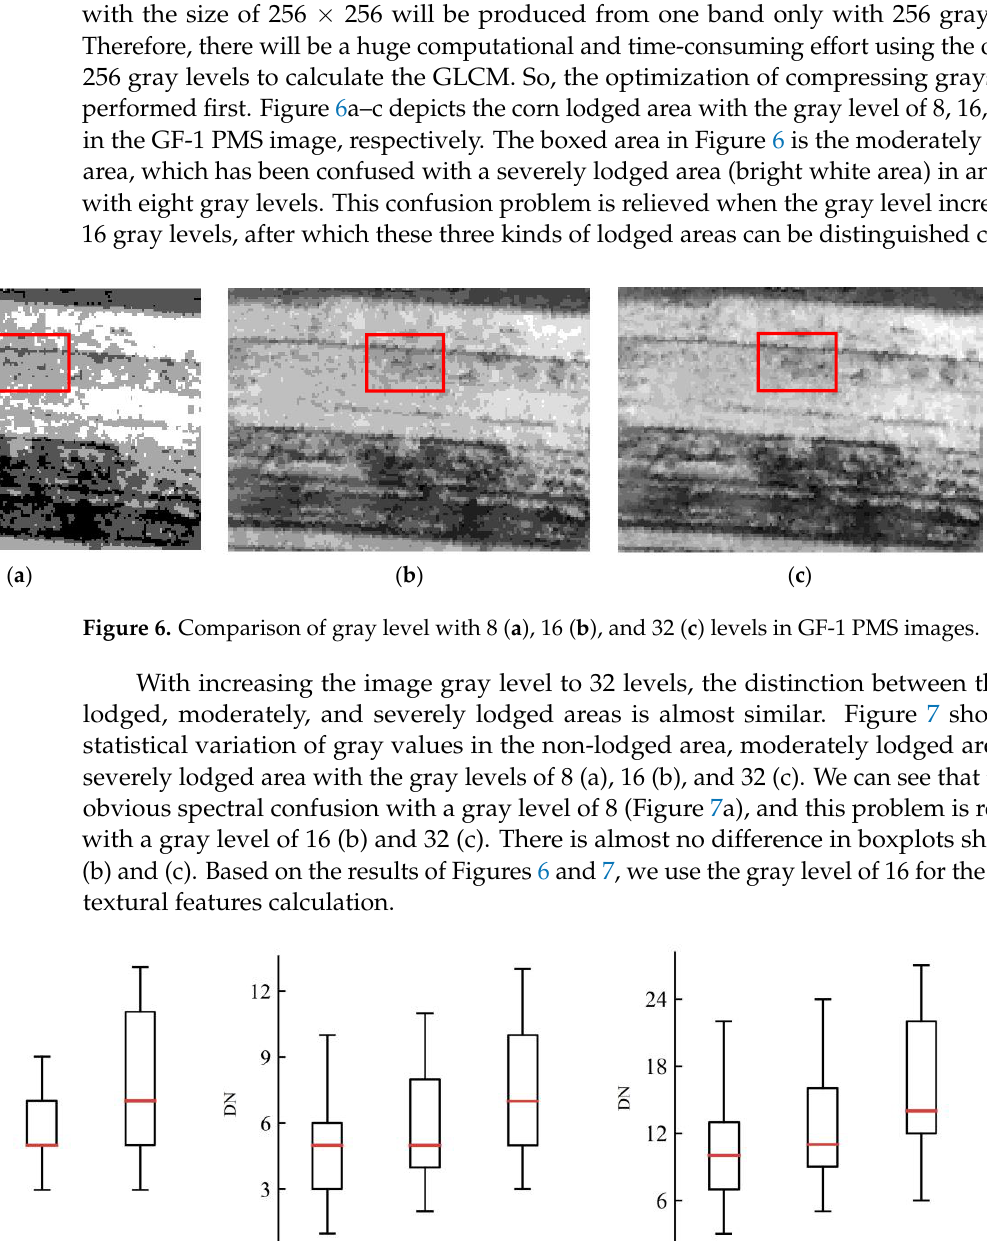
Figure 7. Boxplot of the pixels ’ gray value with the gray level of 8 ( a ), 16 ( b ), and 32 ( c ).